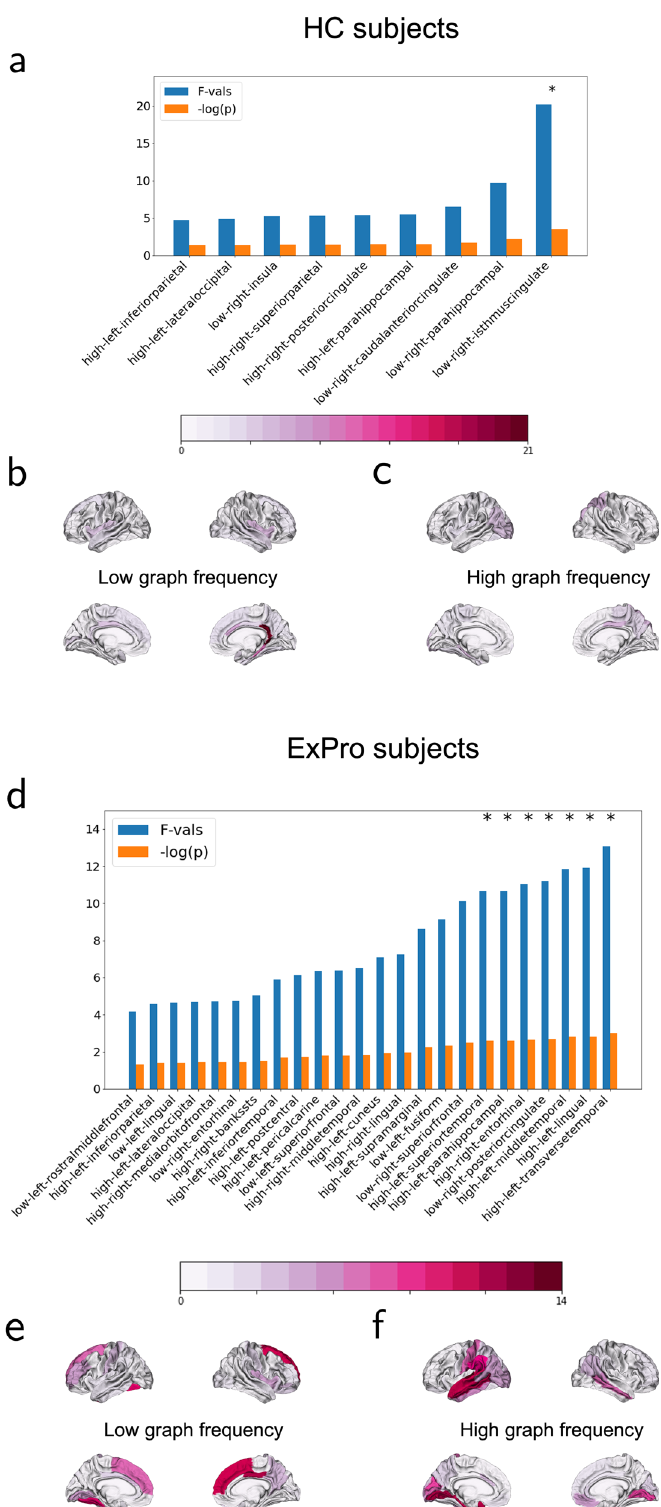
Fig. 2 Univariate feature selection. GSP features with uncorrected p-value < 0.05 and corresponding F-values obtained by linear regression based univariate feature selection for a HC cohort and d ExPro cohort. Higher F-value corresponds to a more signi fi cant linear association between GSP feature and serum NfL. Features with corrected p-value < 0.05 after FDR correction for multiple tests are marked with asterisks (*). Panels b , c plot the F-values for the low and high graph frequency features on a template cortical surface for HC cohort. Panels e , f plot the F-values for the low and high graph frequency features on a template cortical surface for ExPro